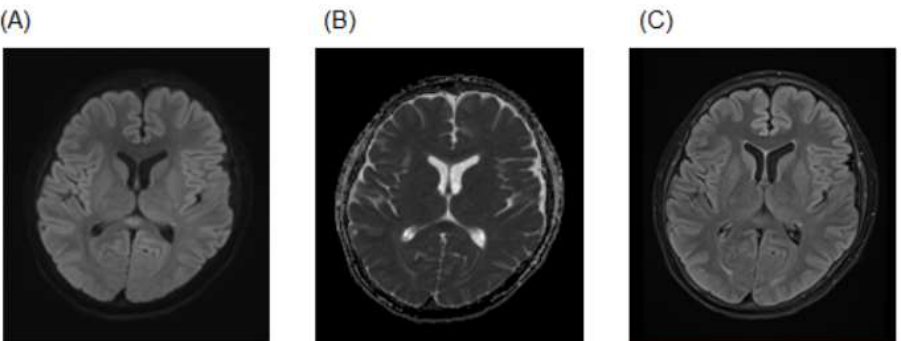
Figure 1. ( A ) Brain MRI on admission showing an oval high-signal area in the midline of the corpus callosum with diffusion-weighted imaging (DWI). ( B ) Apparent diffusion coefficient (ADC) value on ADC map in the same area was low. ( C ) Fluid-attenuated inversion recovery (FLAIR) sequence showed hyperintense lesions in the same area.